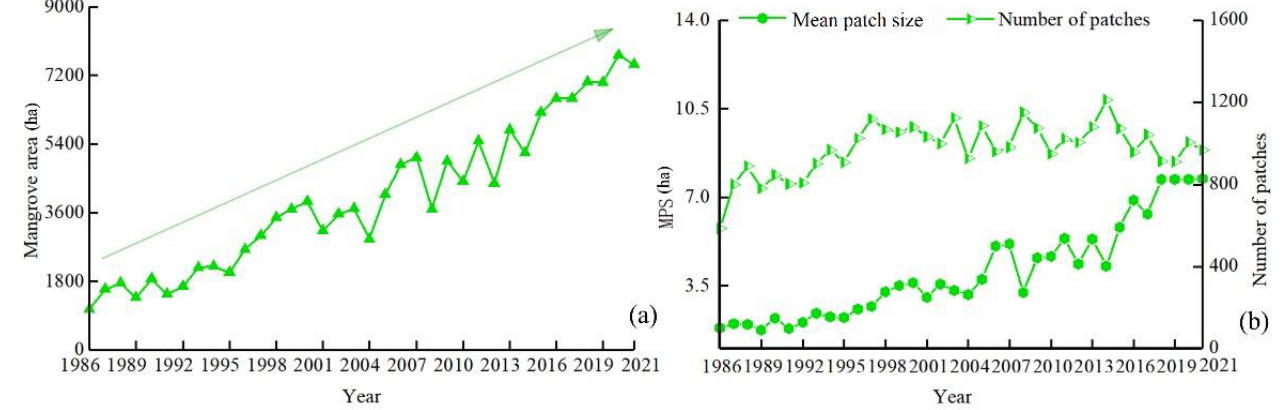
Figure 7. Changes in ( a ) mangrove area and ( b ) the number of mangrove patches and MPS in Guangxi for 1986 – 2021.